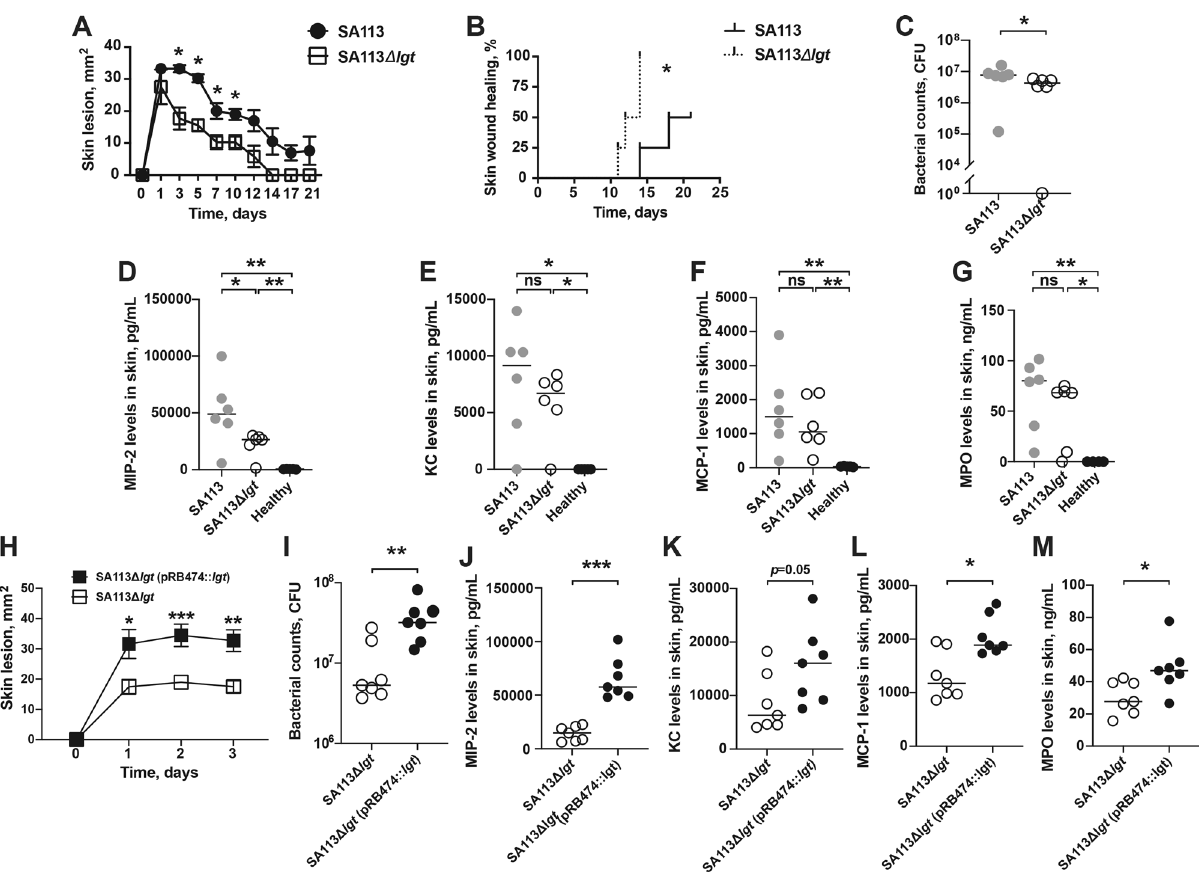
Fig. 3 S. aureus Lpp promote skin abscesses, prolong wound healing, and sustain higher bacterial burden in local skin. The skin lesion size (mm 2 ) ( A ), and skin wound healing ( B ) in NMRI mice ( n = 4/group) up to 21 days after subcutaneous (s.c.) skin injection with 50 μ l of Staphylococcus aureus SA113 parental strain or SA113 Δ lgt mutant strain (7.5 × 10 7 colony-forming units [CFU]/site). Bacterial counts ( C ) and levels of D macrophage in fl ammatory protein-2 (MIP-2), E keratinocyte chemoattractant (KC), F monocyte chemoattractant protein 1 (MCP-1) and G myeloperoxidase (MPO) levels in the supernatant of skin biopsy homogenates from healthy NMRI mice ( n = 4 – 5) or from mice on day 3 after s.c. skin infection with SA113 parental strain or SA113 Δ lgt mutant strain (1.25 × 10 8 CFU/site; n = 6/group). The skin lesion size (mm 2 ) development in NMRI mice ( n = 7/group) up to 3 days ( H ), and bacterial counts ( I ), levels of MIP-2 ( J ), KC ( K ), MCP-1 ( L ) and MPO ( M ) in the supernatant of skin biopsy homogenates on day 3 after s.c. skin infection with 50 μ l of Staphylococcus aureus SA113 Δ lgt mutant strain or complemented mutant SA113 Δ lgt (pRB474:: lgt ) strain (7.5×10 7 CFU/site). The data were pooled from two independent experiments. Statistical evaluations were performed using the Mann – Whitney U test, with data expressed as the mean ± standard error of the mean ( A , H ), or presented as scatterplot with line indicating median value ( C – G , I – M ). Statistical evaluations were performed using Mantel – Cox log-rank test ( B ). * P < 0.05; ** P < 0.01; *** P < 0.001; ns = not signi fi